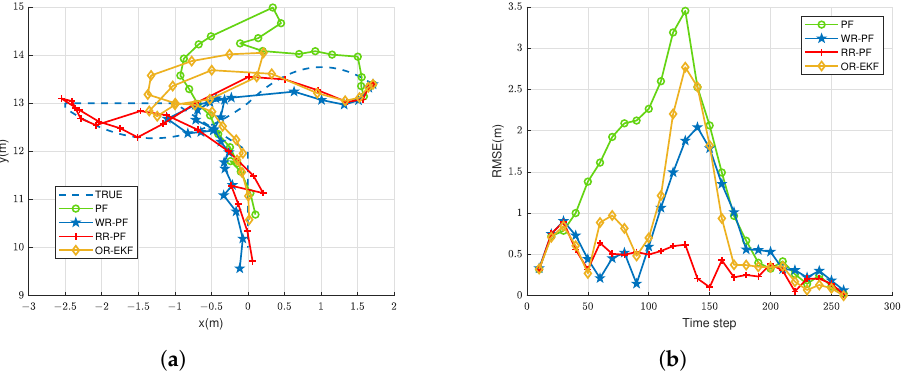
Figure 14. Performance comparisons of tracking results in the real data. ( a ) Tracking results based on real data. ( b ) RMSE